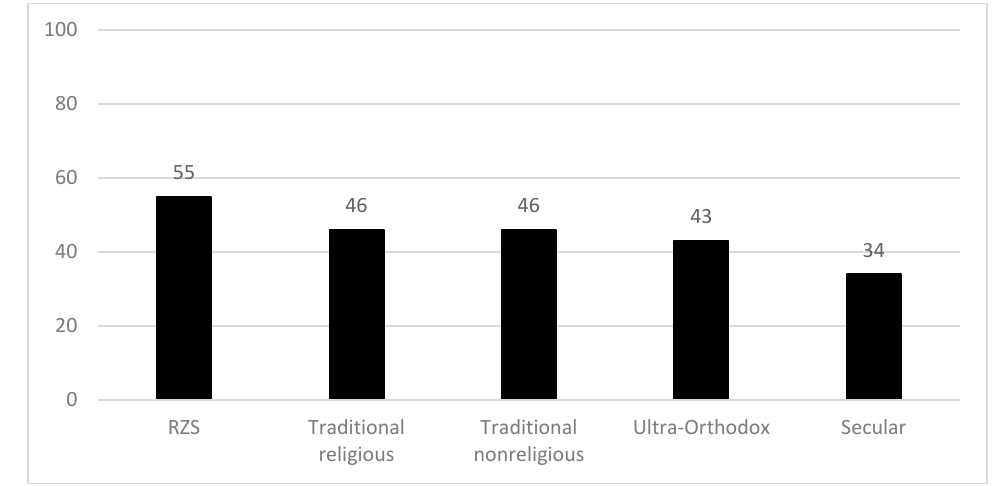
Figure 5. Proud to be Israeli, by level of religiosity (%) (Source: Israeli Democracy Index, 2014 ‒ 2021).